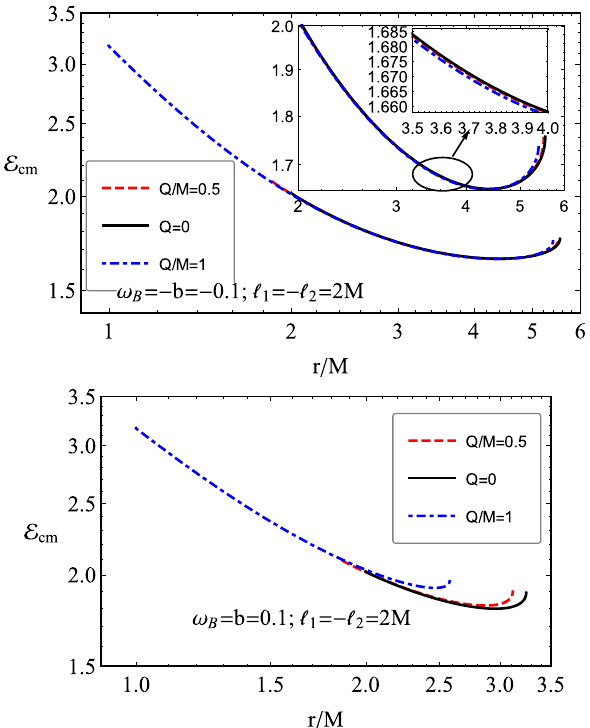
Fig. 14 Dependence of center-of-mass energy of collisions of posi- tively (on the top panel) and negatively (on the bottom panel) charged particles and magnetized particles with the same value of initial energy = E = 1 and magnetic coupling parameters, around electrically E 1 2 charged RN black hole for the different values of the black hole charge